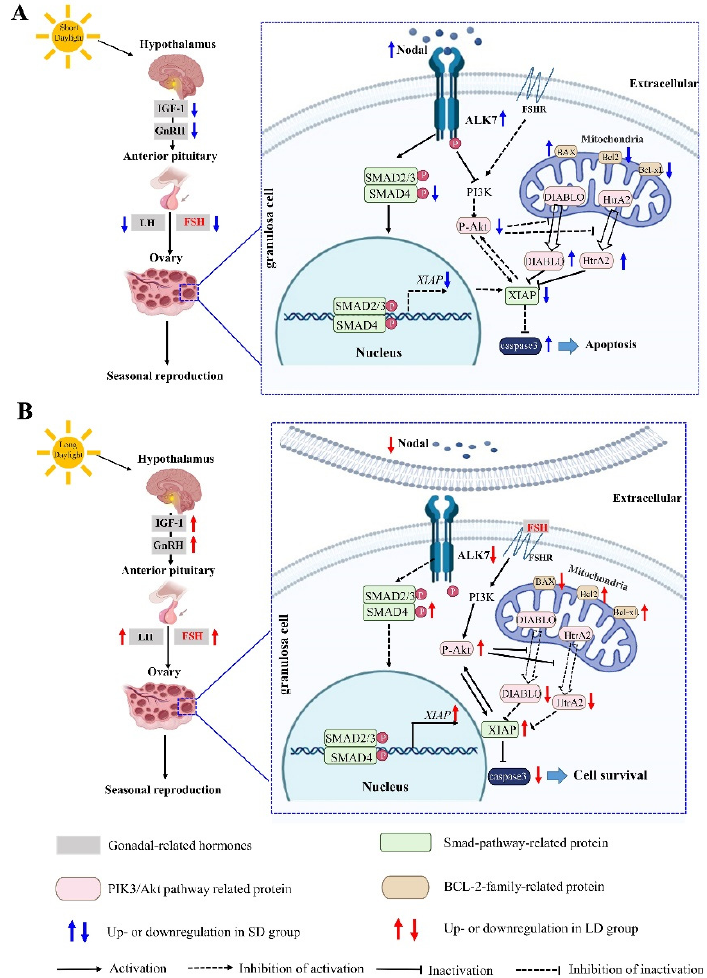
Figure 12. Molecular mechanism diagram of the photoperiod regulating the seasonal reproduction in female Phodopus sungorus . ( A ) Regulation mechanism of FSH-Nodal/ALK7 signal pathway under short daylight condition. ( B ) Regulation mechanism of FSH-Nodal/ALK7 signal pathway under long daylight condition. IGF-1: insulin growth factor 1; GnRH: gonadotropin-releasing hormone; FSH: follicle-stimulating hormone; LH: luteinizing hormone; ALK7: activin receptor-like kinase 7;